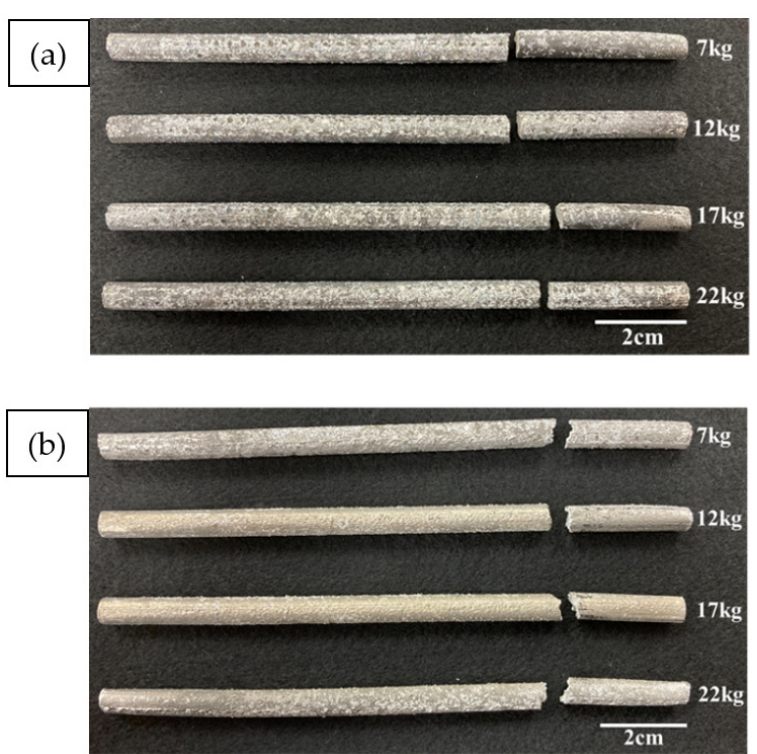
Figure 8. Macroview of the fatigue fracture of the Al-Ni-Cu alloy before and after solution treatment: ( a ) As-printed and ( b ) 530 °C for 1 h and 175 °C for 6 h specimen.